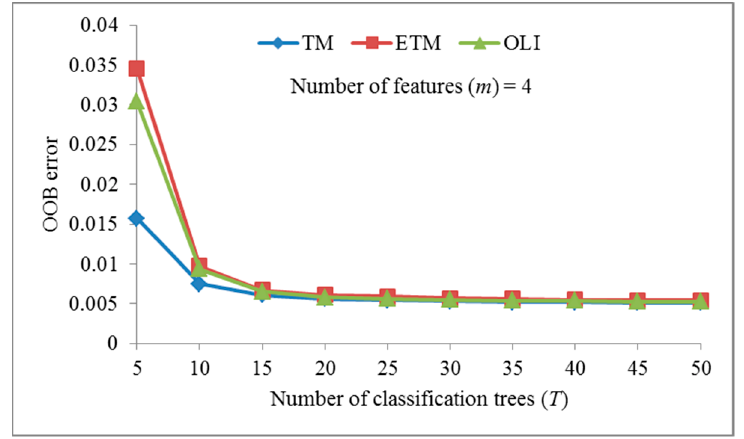
Figure 4. Impacts of different numbers of trees in the Random Forest based on OOB error assessment.